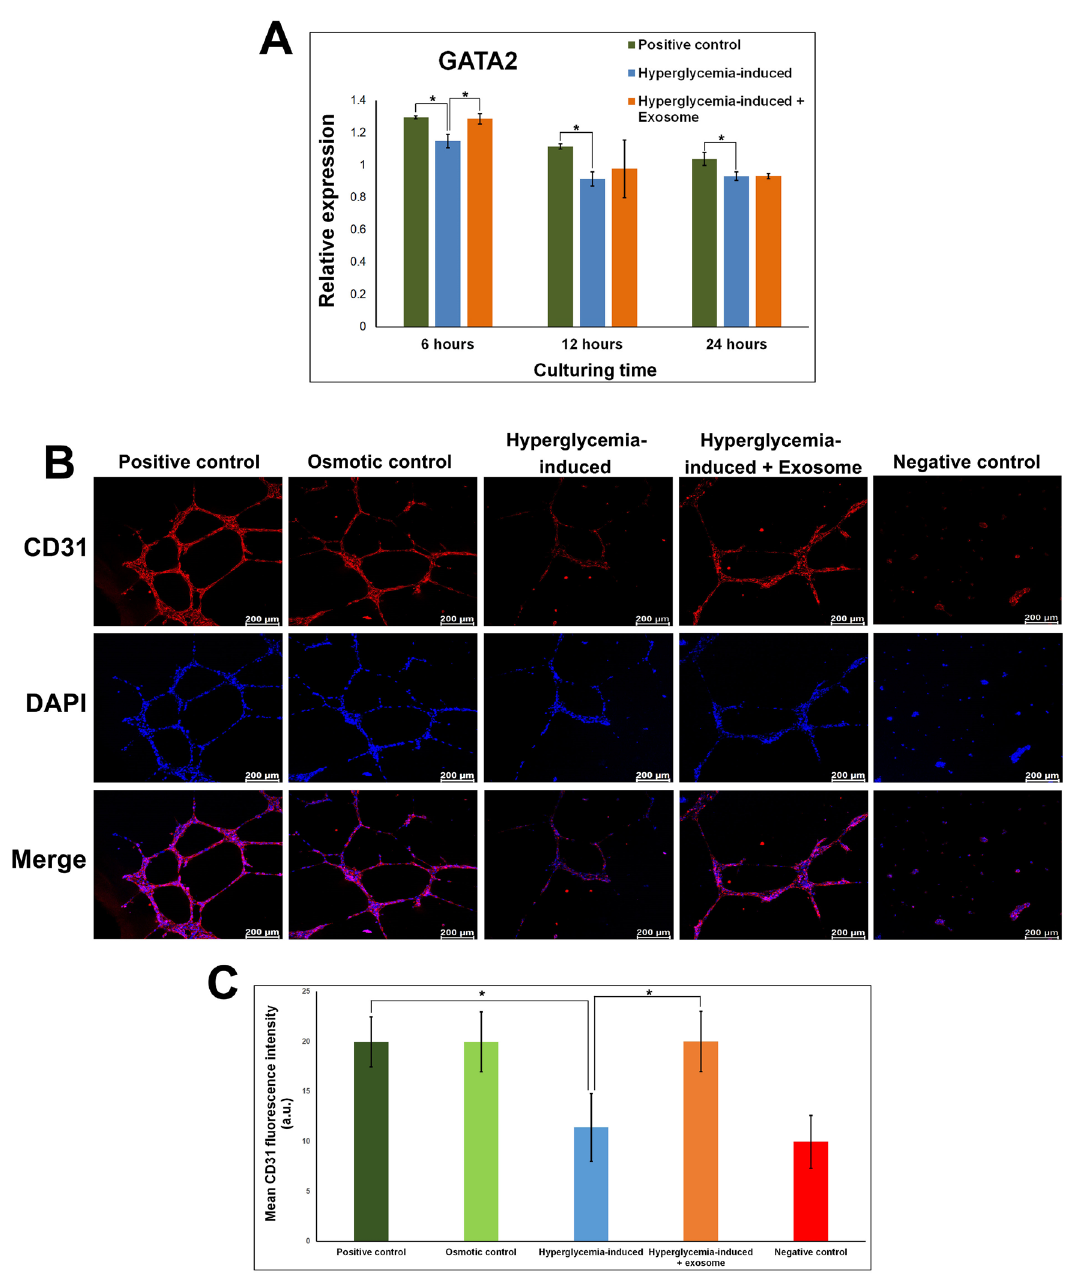
Figure 4- SHED-exosomes enhance angiogenesis gene and protein expression of hyperglycemia-induced HUVEC. (A) Quantitative real-time PCR relative GATA2 gene expression level of cells in various groups at hours 6, 12, and 24. The bar charts represent the mean of gene expression relative to GAPDH expression, with the error bar showing the standard deviation of gene expression. * indicates a statistical difference between the groups (p=0.03). (B) Immunofluorescence images of tube network structures in five sample groups in 12 hours; the upper panel shows CD31 expression (red), the middle panel shows DAPI (blue), and the lower panel shows a merge between CD31 and DAPI. Scale bars = 200 µm. (C) Graph represents the mean fluorescence intensity of CD31 for positive control, osmotic control, hyperglycemia-induced, hyperglycemia-induced + exosome, and negative control groups. * indicates a statistical difference between the groups